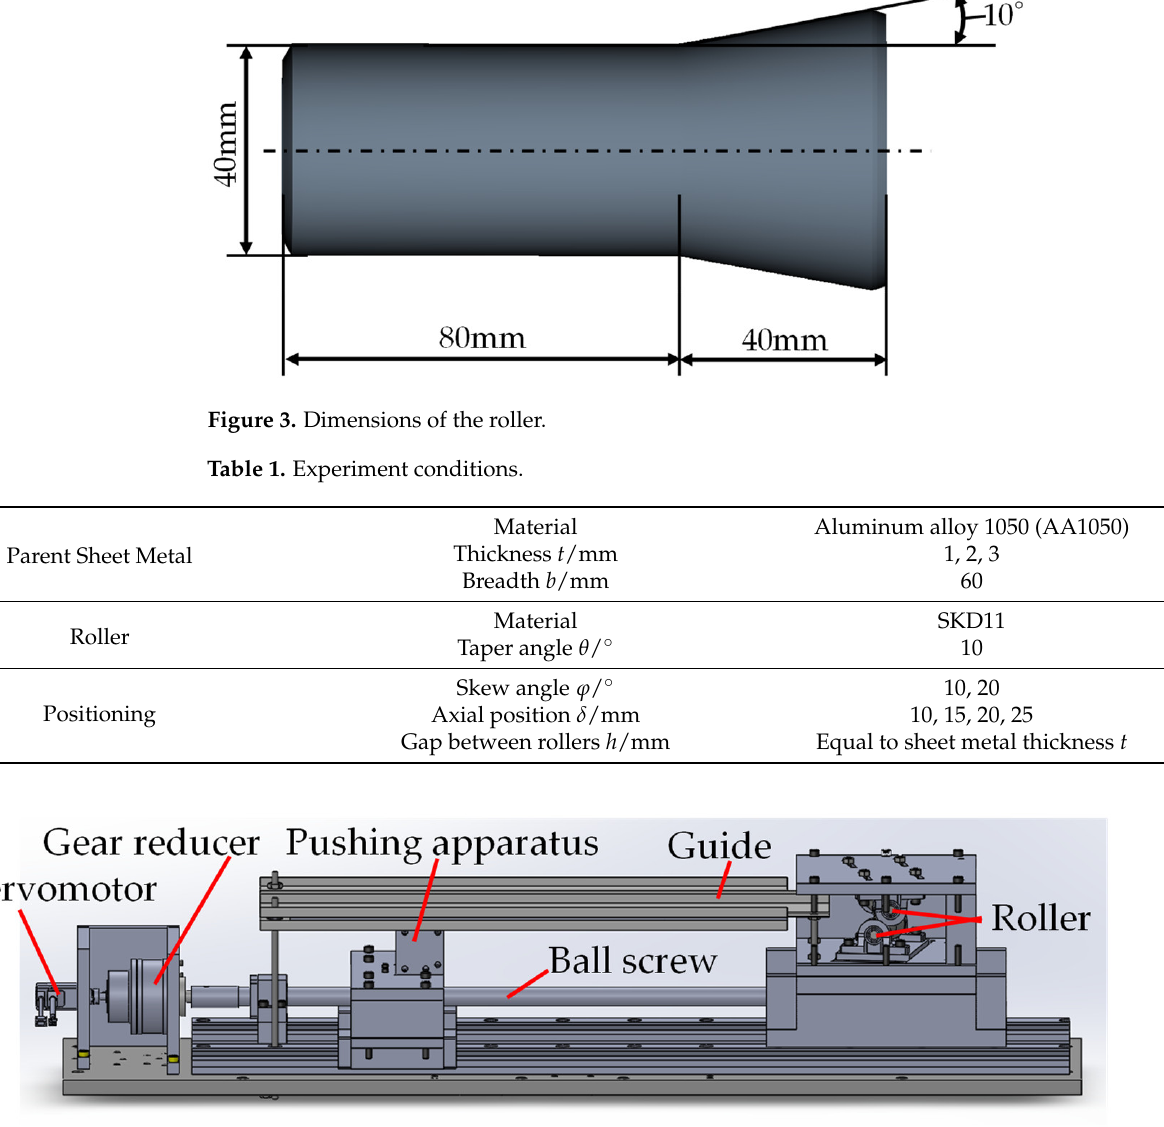
Figure 4. Schematic diagram of the experimental machine. Table 2. ( Z B , Y B ) coordinates in each condition.